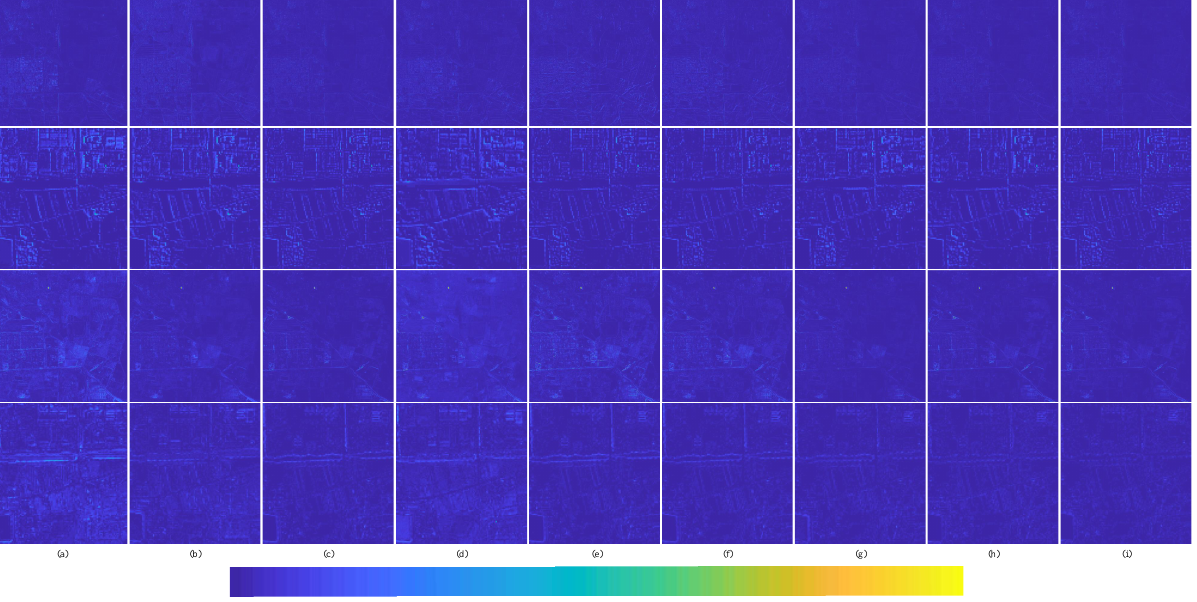
Figure 15. Average intensity difference maps and average spectral difference maps between the pan-sharpened MS image and ground-truth MS image for the Landsat-8 testing dataset with reduced resolution; the top row are the average intensity difference maps of the whole image, the second row are the average intensity difference maps of the enlarged area in Figure 14, the third row are the average spectral difference maps of the whole image, and the bottom row are the average spectral difference maps of the enlarged area in Figure 14. ( a ) Brovey; ( b ) GS; ( c ) SFIM; ( d ) IFCNN; ( e ) PNN; ( f ) DRPNN; ( g ) PanNet; ( h ) ResTFNet; ( i ) RDFNet